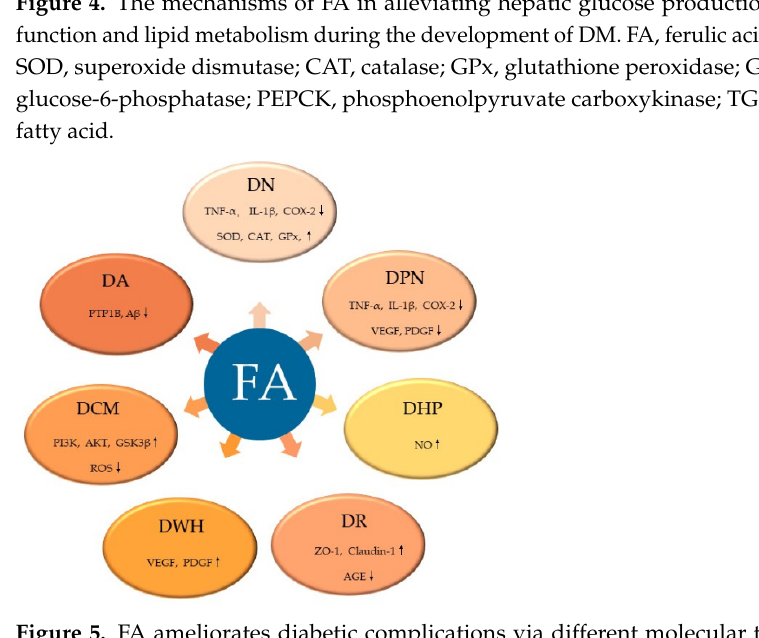
Figure 5. FA ameliorates diabetic complications via different molecular targets. FA, ferulic acid; SOD, superoxide dismutase; CAT, catalase; GPx, glutathione peroxidase; TNF- α , tumor necrosis factor- α ; IL-1 β , interleukin-1 β ; COX-2, cyclooxygenase-2; VEGF, vascular endothelial growth factor; PDGF, platelet derived growth factor; NO, nitric oxide; AGE, advanced glycation end products; ZO-1, zonula occluden-1 (ZO-1); PI3K, phosphoinositide-3 kinase; AKT, protein kinase B; ROS, reactive oxygen species.